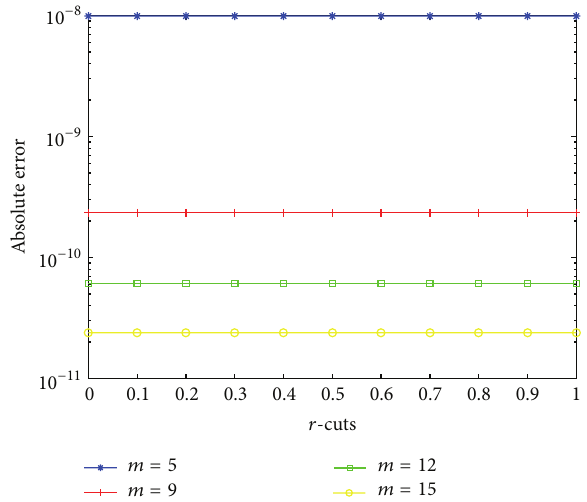
Figure 5: The absolute error for different values 𝑚 with V = 𝛼 = = 0.012 , and 𝑘 = 0.001 0.75 , 𝑘 1 2